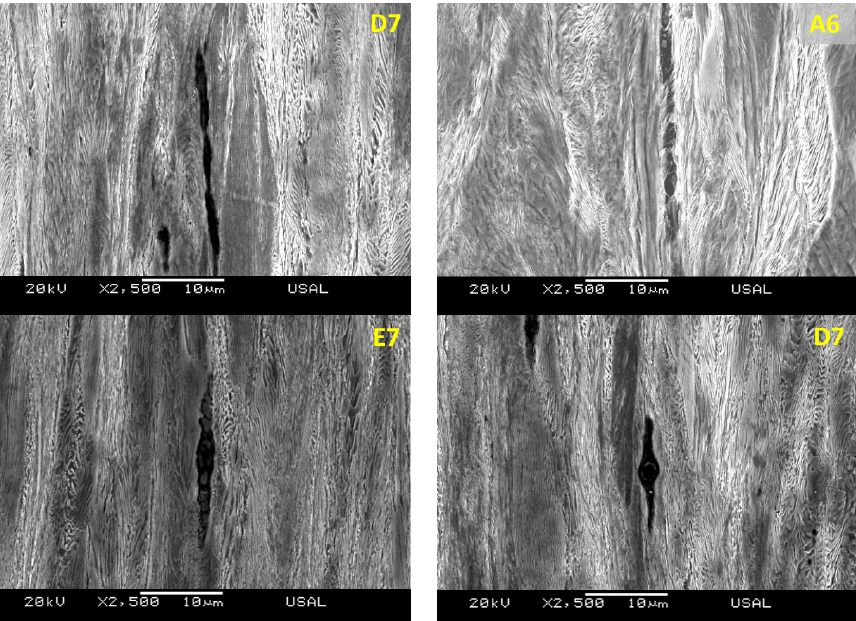
Figure 11. Axial micro-cracks generated by the presence of inclusions in heavily drawn pearlitic steels (commercial prestressing steel wires) (2500×).